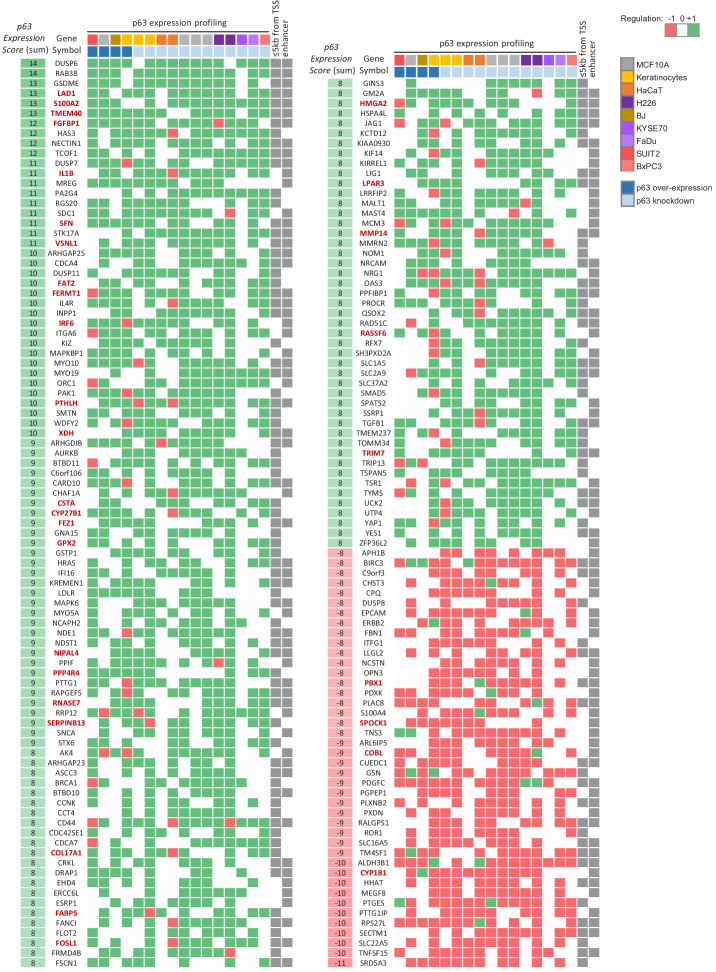
Complement to Table 1.Genes identified as significantly up- or down-regulated in at least the half of all datasets (|p63 Expression Score|| ≥ 8) that are linked to p63-binding sites supported by at least half of all datasets (≥10) through binding within 5 kb from their TSS or through double-elite enhancer:gene associations (Fishilevich et al., 2017). Using these thresholds we identified 138 and 42 high-probability candidates as directly up- and down-regulated by p63, respectively. Gene names marked in red are also up- or down-regulated across SCCs (Cancer Genome Atlas Research Network et al., 2018).